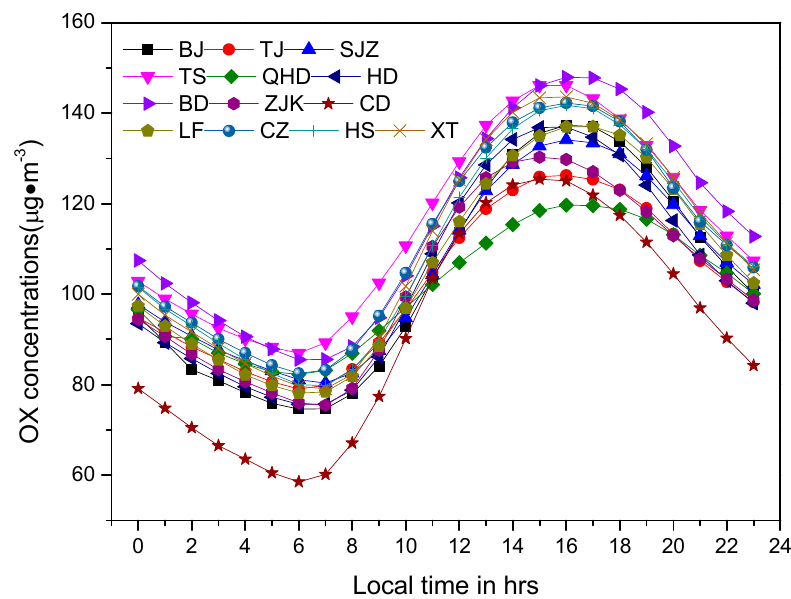
Figure 6. Average diurnal pattern of OX in BTH area.